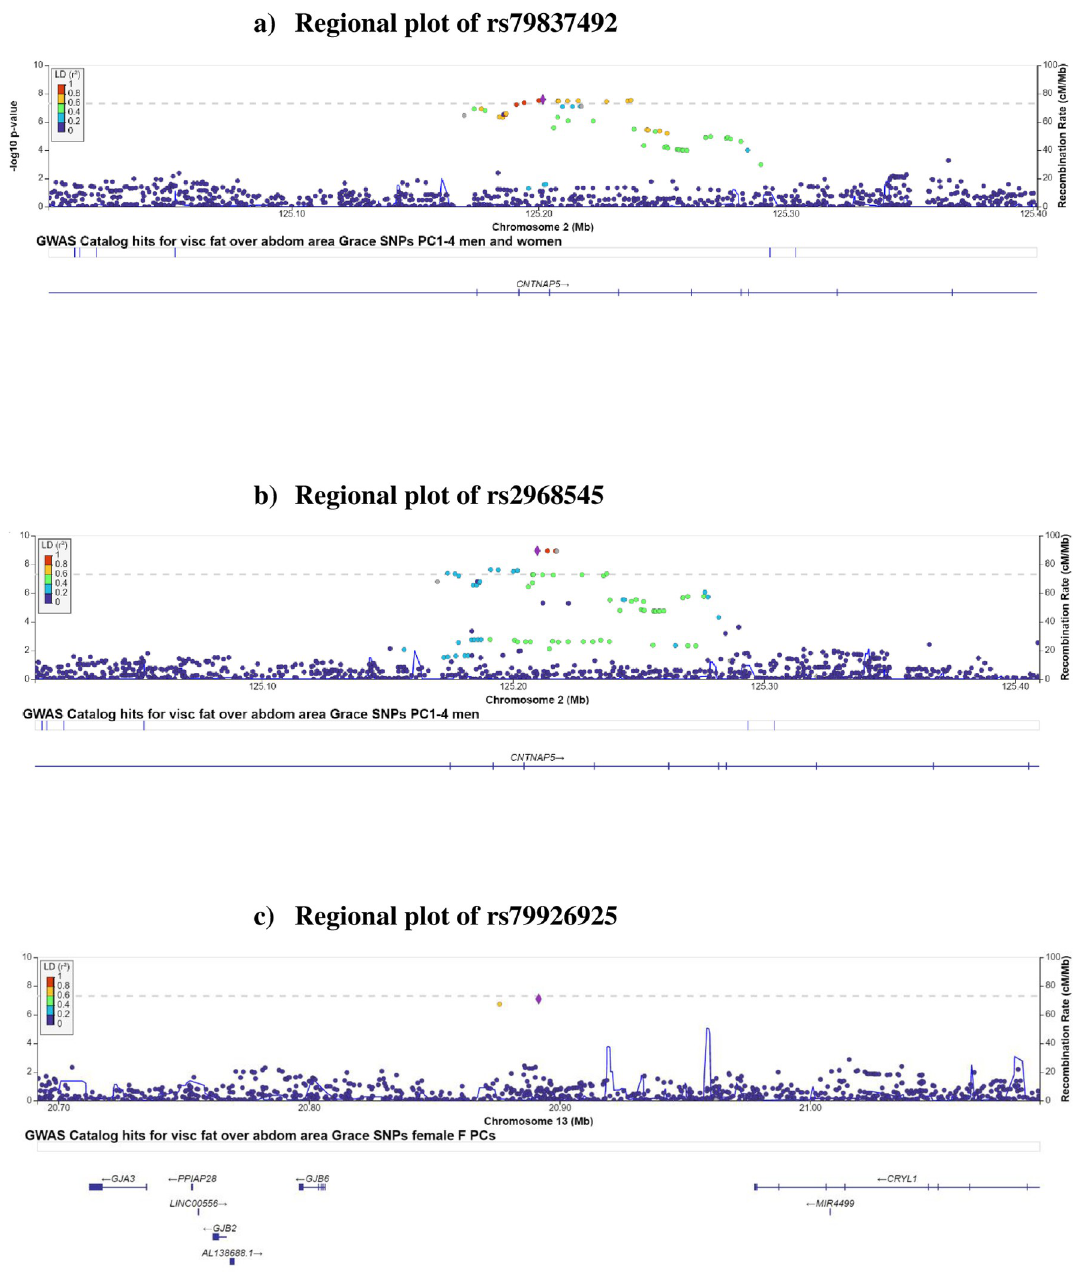
Fig 2. Regional plots of SNP P-values in a +/-200 kb window around rs79837429, rs2968545, and rs79926925. The X-axis shows the chromosome and physical location (Mb), the left Y-axis shows the negative base ten logarithm of the P-values, and the right Y-axis shows recombination activity (cM/Mb) as a blue line. Positions, recombination rates, and gene annotations are according to NCBI’s build 37 (hg 19) and the 1000 Genomes Project Phase 3 multiethnic data set: a) Regional plot of rs79837429, b) Regional plot of rs2968545, c) Regional plot of